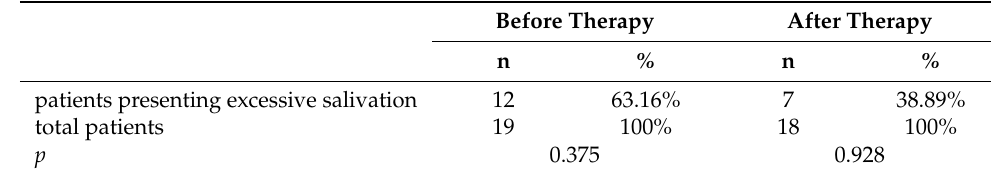
Table 4. The comparison of the number of patients presenting salivation before and after